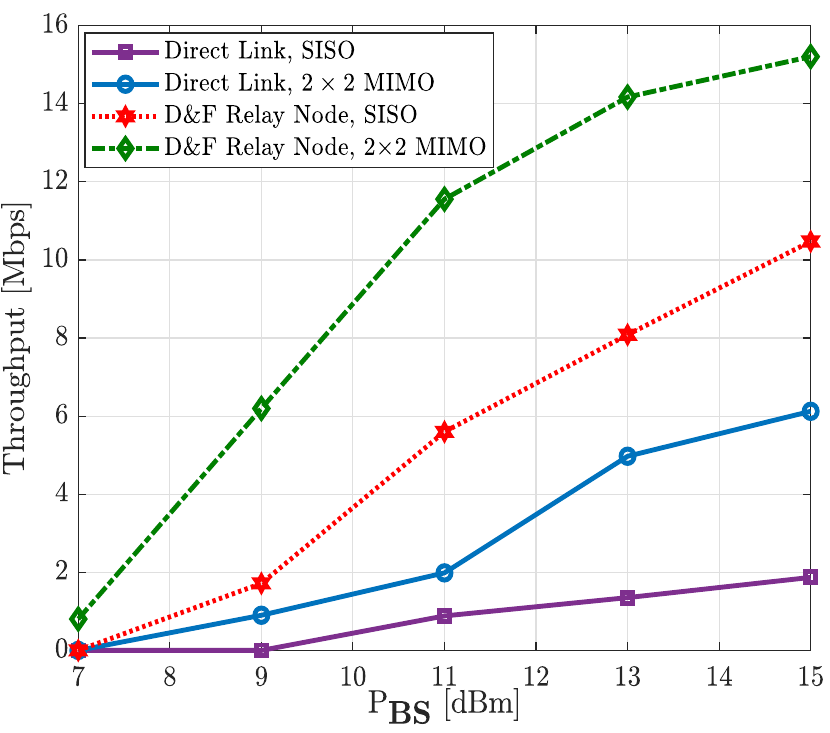
Figure 20. Throughput vs. P BS of the relay node co-operative 5G network;